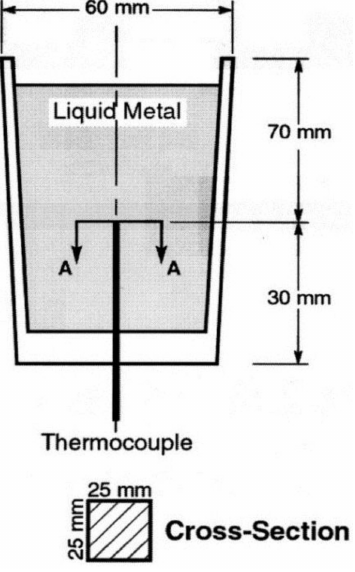
Figure 1. Schematic sketch showing the graphite mold used in this